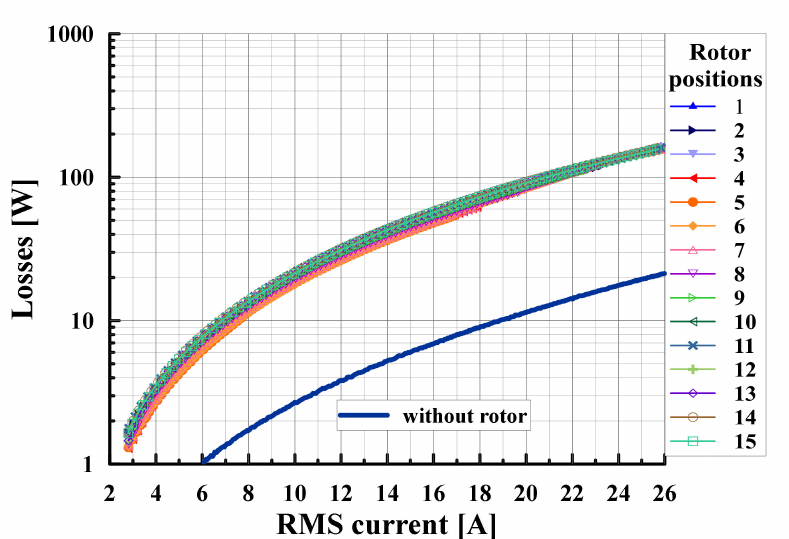
Figure 13. Stator losses as a function of current at different rotor positions at a frequency of 100 Hz. Same frequency without rotor is depicted for